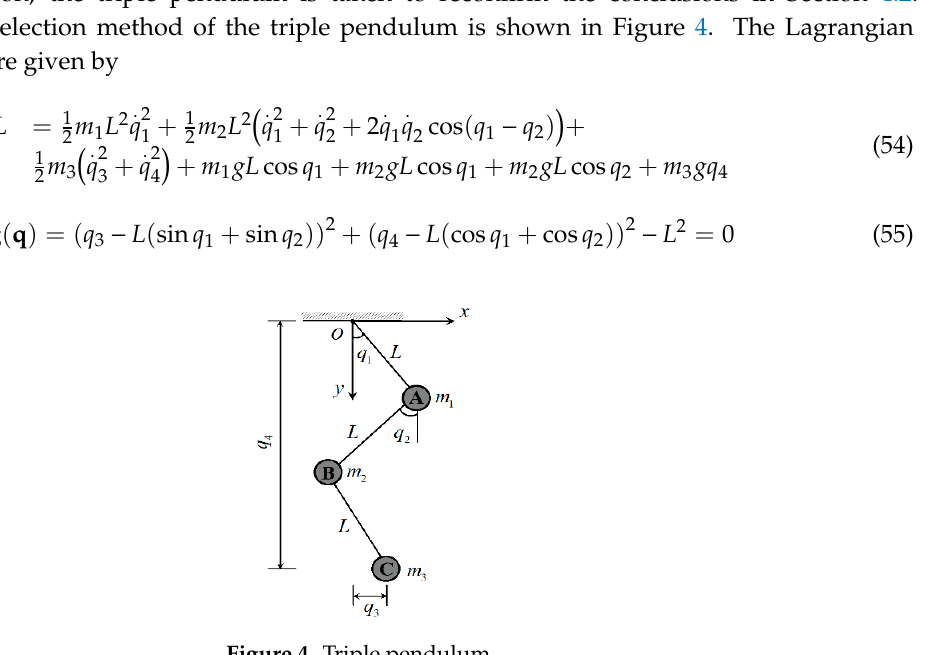
Figure 4. Triple pendulum. Figure 4. Triple